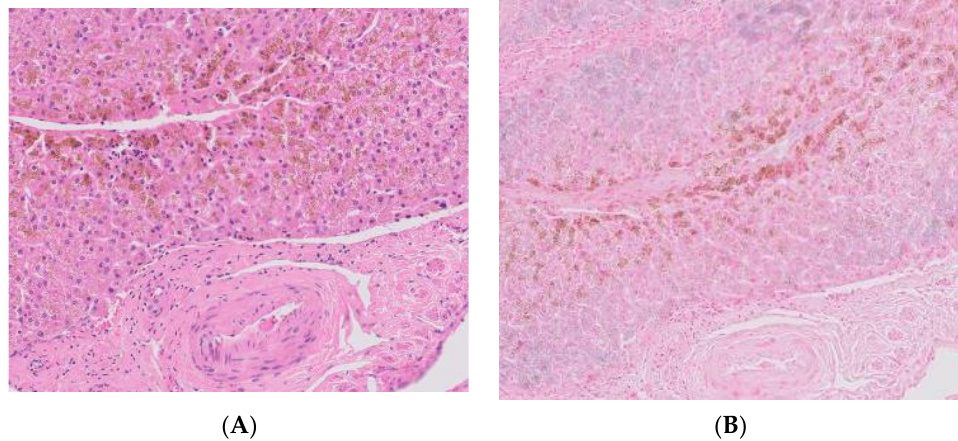
Figure 2. Liver biopsy specimen. ( A ) Dark brown granules in centrilobular hepatocytes are noted via hematoxylin and eosin staining. ( B ) No signs of hemosiderin deposition were noted with Prussian blue staining.